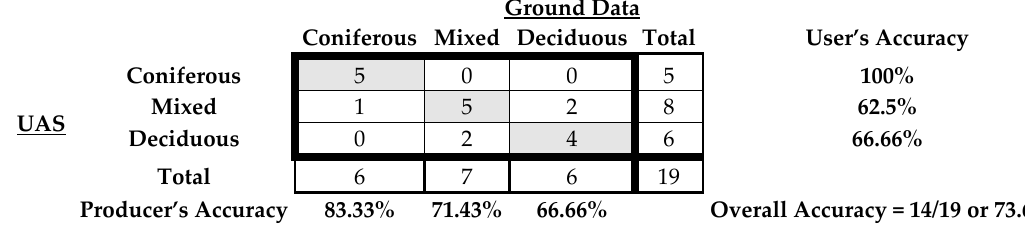
Table 4. CFI plot-registered PBC thematic map error matrix. Ground (reference) data are represented Table 5. Stratified randomly distributed OBC reference data subsample error matrix. Ground by the CFI plots and Unmanned Aerial Systems (UAS) data are derived from the corresponding (reference) data are represented by the CFI plots and Unmanned Aerial Systems (UAS) data are orthomosaic. derived from the corresponding orthomosaic.